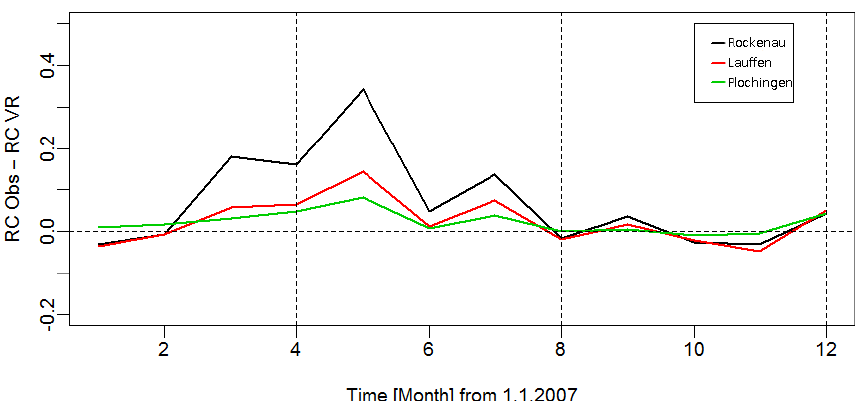
Figure 12. Differences between the runoff coefficient calculated for the three stations for the year 2007 based on observations and simulation.